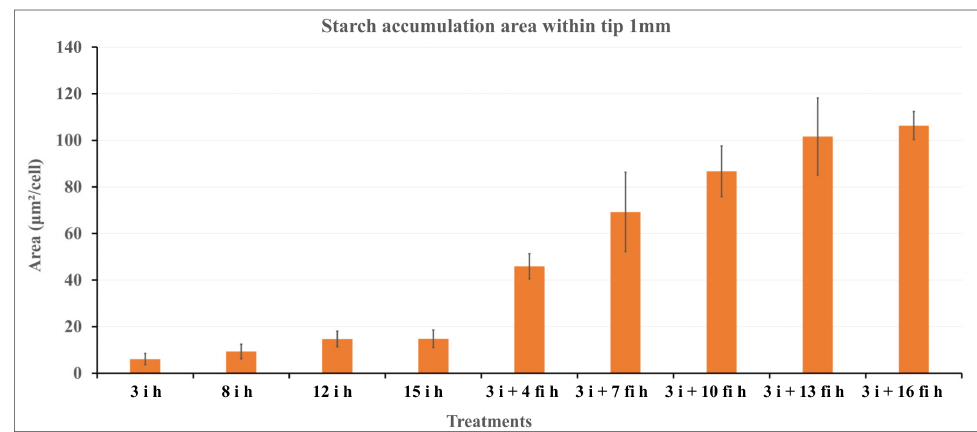
Figure 9. Area occupied by starch ( µ m 2 /cell) in the radicle cells of embryonic axes under various treatments. Starch grains per cell increased significantly after excised embryonic axes were placed on wet filter paper. The longer the wet filter incubation time, the more starch grains occupied the cells. Bars represent the standard deviation